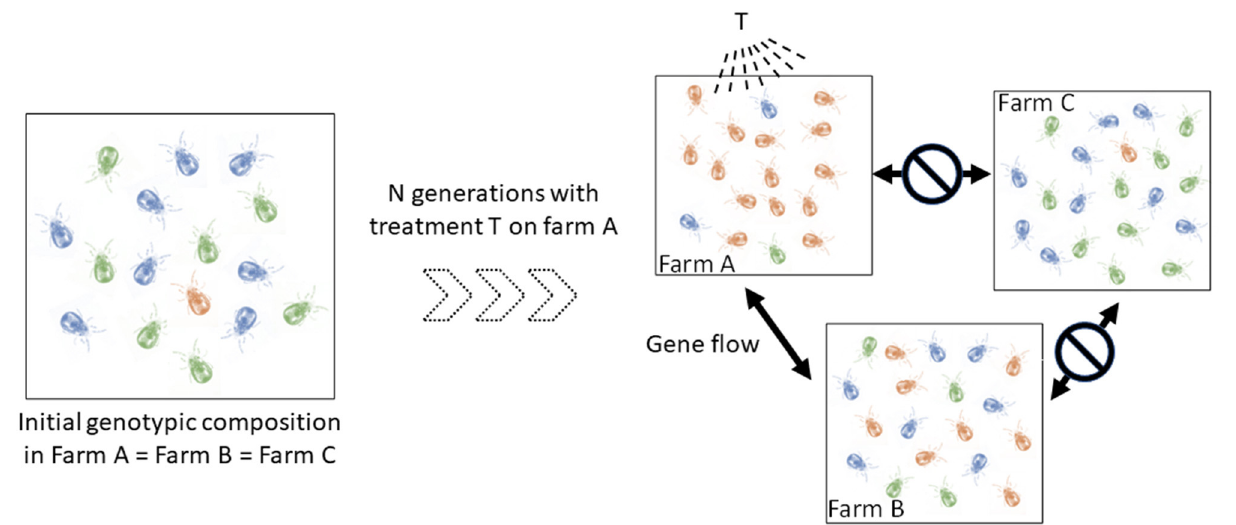
FIGURE 1 | Schematic illustration of the implication of spatio-temporal dynamics in the diffusion of a dominant resistance to antiparasitic agents. Let consider three hypothetical farms, two of which are interconnected (farm A, farm B), i.e., they exchange mites regularly, and one isolated farm (farm C). Left, the blue and green genotypes are sensitive to the T treatment (only sensitive alleles), the orange is resistant to it (i.e. any genotype containing the resistant allele) (to simplify, we start from identical initial genotypic compositions in the three farms, with the resistant genotypes (i.e. any genotype containing the dominant allele) being very infrequent). Right , genotypic composition after a certain number of generations of mites having undergone the selective pressure of the T treatment in farm A and having received no treatment in farms B and C. In farm A, mites carrying the resistant allele (orange) were favored by the T treatment and thus transmitted this allele to a large number of offspring. The resistant genotypes thus became the majority. Because of the gene flow between farms A and B and the isolation of farm C, this resistant allele has increased in frequency in farm B and not in farm C. If farmers B and C start applying the T treatment at this time, the former is likely to experience treatment failures very quickly, while the latter will be able to treat effectively for some